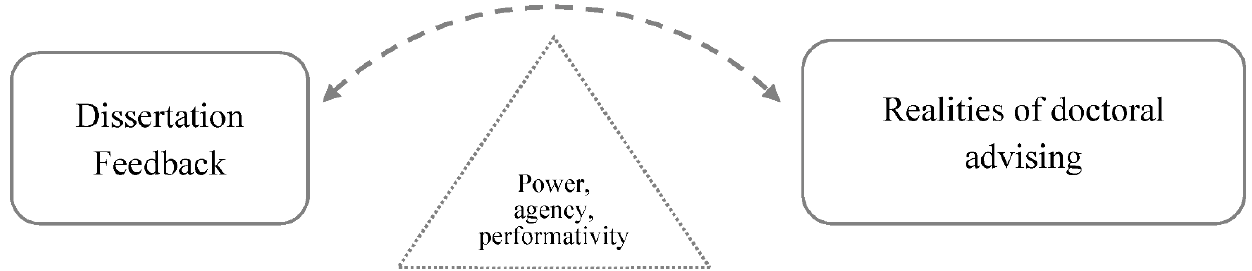
Figure 5. Power, agency, and performativity.